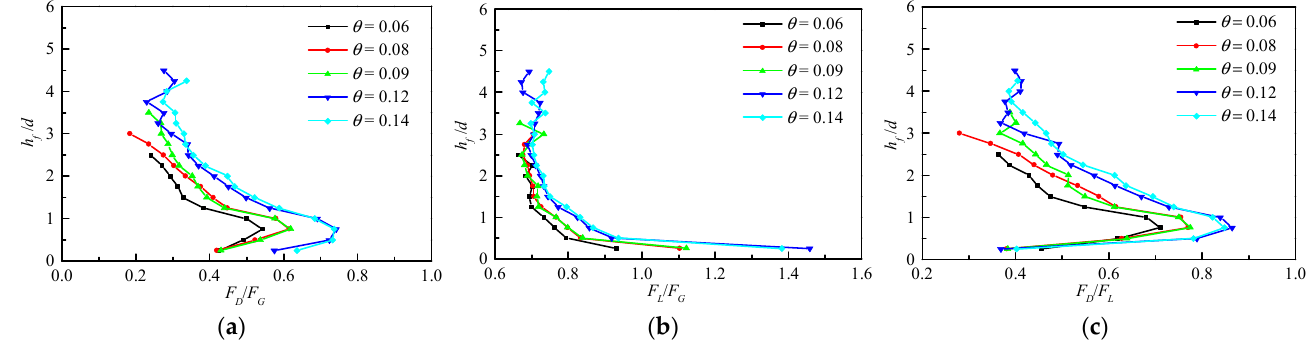
θ with transport stage [9,18]. Figure 15. Incidence angles θ in and takeoff angles θ out with transport stage [9,18]. out